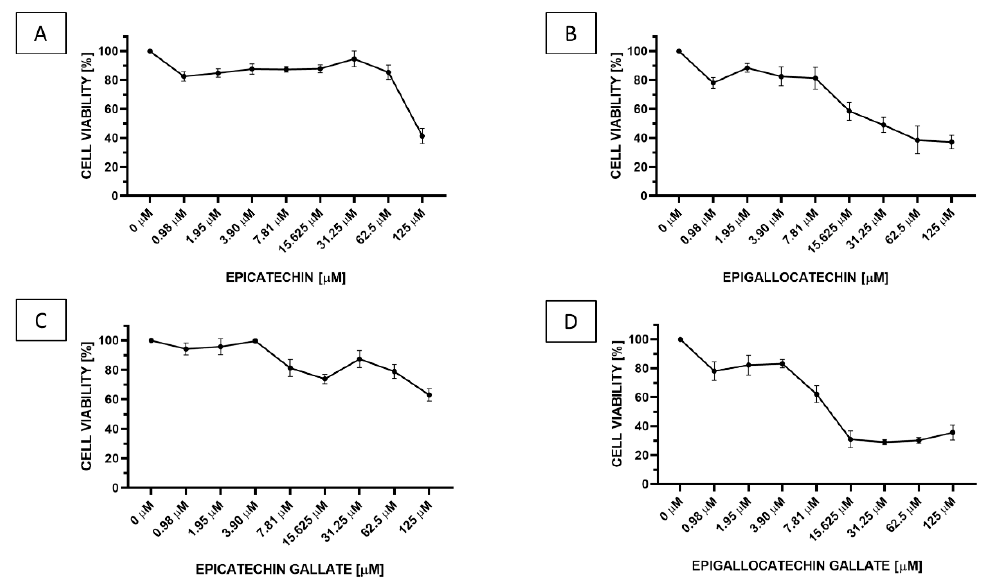
Figure 3. The cellular viability of MCF-7 after 24 h incubation with di ff erent concentrations of ( A ) epicatechin, ( B ) epigallocatechin, ( C ) epicatechin gallate, and ( D ) epigallocatechin gallate. The cellular viability was measured by MTT Cell Viability assay. The results were presented as a percentage of control (mean ± SD, n = 3).